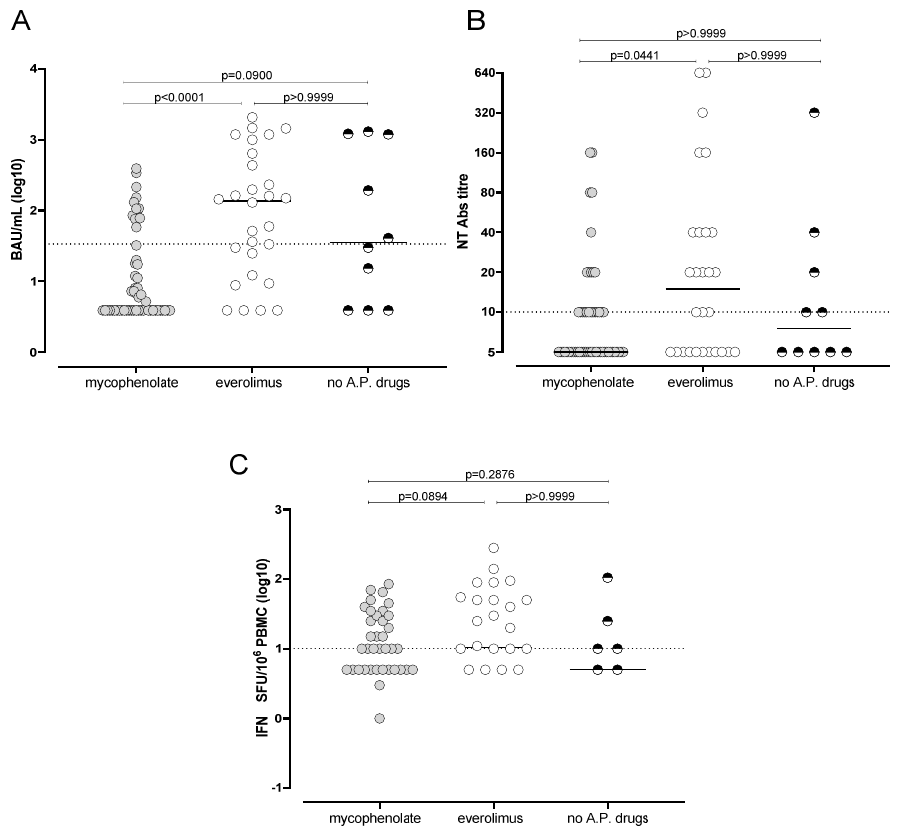
Figure 2. Total IgG SARS-CoV-2 response measured by Trimeric ( A ) assay, SARS-CoV-2 NT Abs level ( B ) and Spike-specific response-cell response ( C ) were compared in subjects treated with mycophenolate ( n = 55), everolimus ( n = 28) or without antiproliferative drugs ( n = 10). p values were obtained by Kruskall–Wallis test and given for each graph. No A.P. drugs: no antiproliferative drug administered .